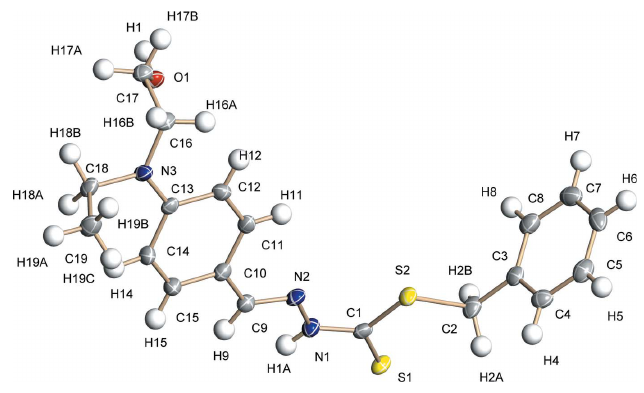
Figure 1 The molecular structure of the title compound showing 50% displace- ment ellipsoids.